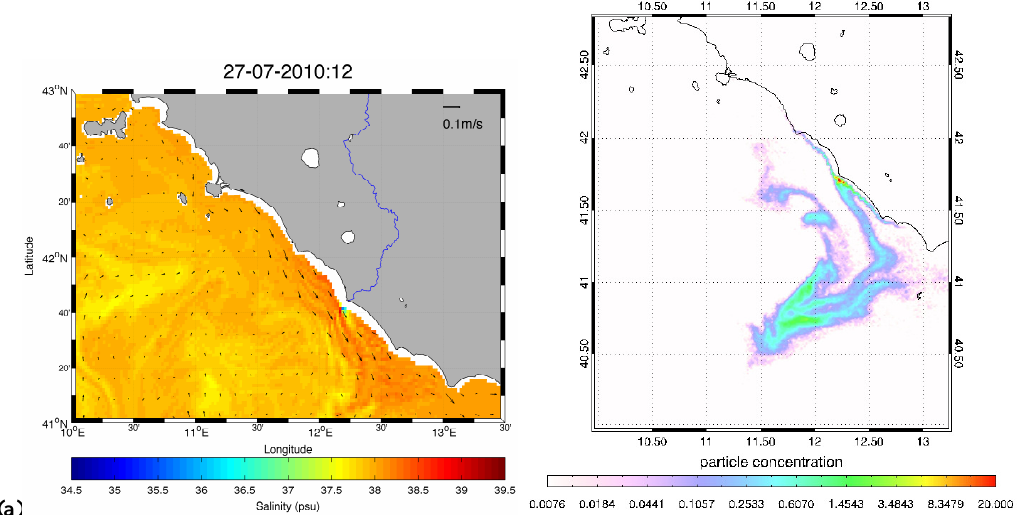
(a) Fig. 12. (a) 27 July 2010, salinity at − 5m. (b) 27 July 2010, map of pollutant dispersion; units (gm − 2 ), logarithmic Fig. 12a. 27 July 2010, salinity at –5 m. Fig. 12b. 27 July 2010, map of pollutant dispersion; units ( gm − 2 ), logarithmic scale. 36 Fig. 11b. 2 August 2010, map of K490 ; units ( m − 1 ), logarithmic scale.